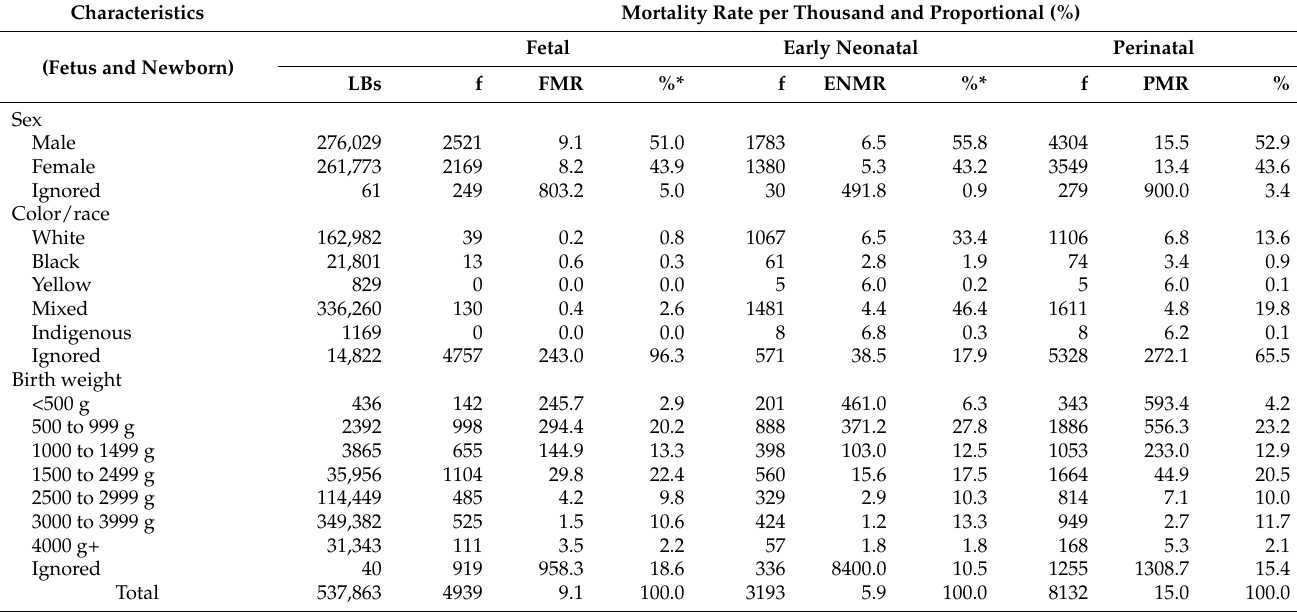
Table 3. Perinatal, fetal, and early neonatal mortality due to the characteristics of the stillbirth and the newborn. Esp í rito Santo, Brazil,